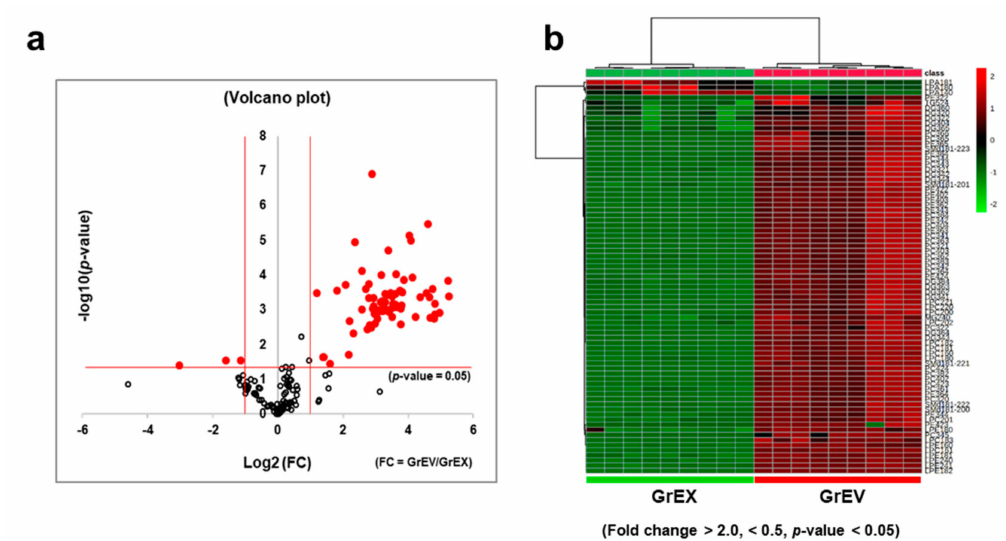
Figure 7. Differentially enriched lipid species and lipid composition and proportion in ginseng root-derived extracellular vesicles (GrEVs) versus ginseng root extracts (GrEXs). ( a ) The 188 identified lipids in GrEVs are represented in a volcano plot according to their statistical p -values and fold-changes when compared to those detected in GrEXs. The red lines at the left and the right sides represent distinct boundaries for lipid species with a <0.5-fold decrease or a >2.0-fold increase, respectively, in GrEVs (when compared to those in GrEXs. The horizontal red line represents the boundary for the significance ( p < 0.05). ( b ) A heat map graphically represents the differential fold changes of 73 lipid species in GrEVs compared to the corresponding levels in GrEXs (fold change >2.0 or <0.5, p < 0.05). The relative differences are indicated by the color intensity, where red shading indicates increased levels and green shading indicates decreased